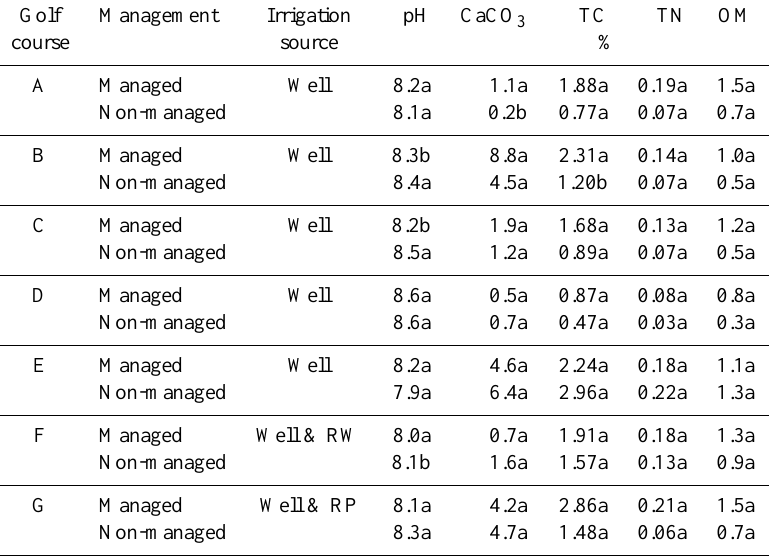
Table 1. Selected soil properties examined at the managed and non-managed areas of the seven golf facilities in Lubbock, Texas, USA ( n =